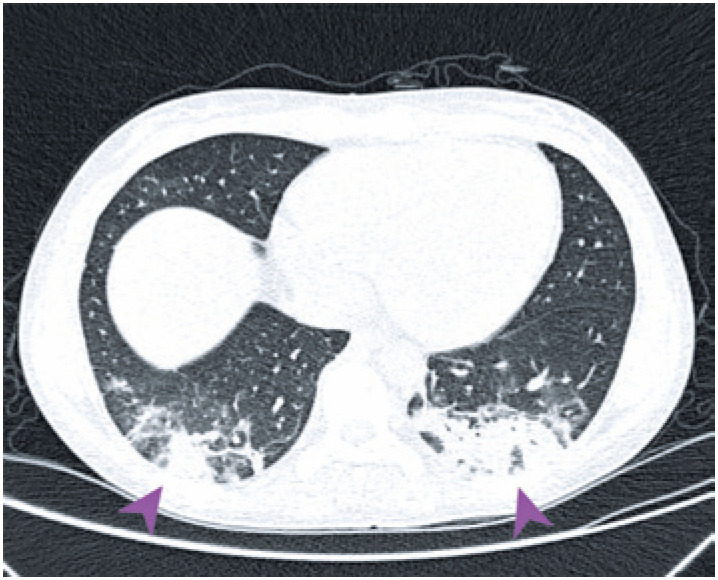
Corte axial da tomografia computadorizada de tórax sem contraste, evidenciando opacidades bilaterais nas bases pulmonares, com predomínio periférico e posterior, suspeitas de acometimento por COVID-19